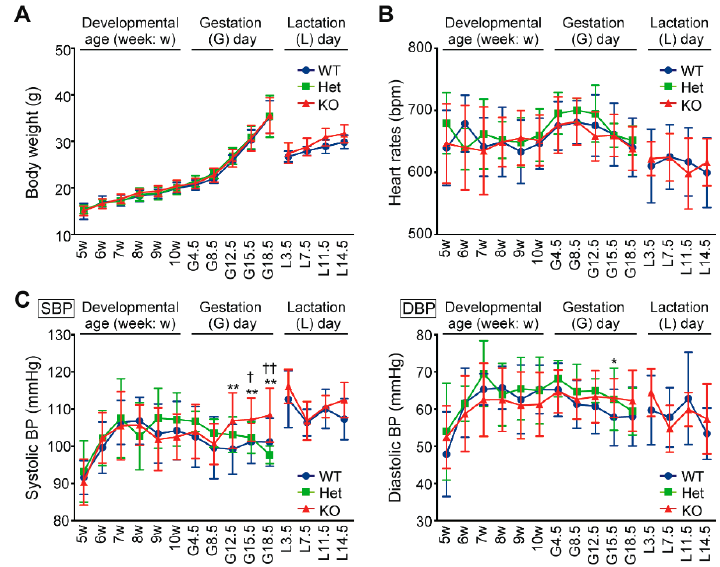
Figure 1. Pregnancy-induced hypertension in Cth − / − dams. Changes in body weights ( A ), heart rates ( B ), and systolic/diastolic blood pressures (SBP/DBP) ( C ) of wild-type ( Cth +/+ , WT, blue ), heterozygous ( Cth +/ − , Het, green ), and homozygous ( Cth − / − , KO, red ) female mice during juvenile development (5–10 week), gestation days (G4.5–G18.5), and lactation days (L3.5–L14.5). Blood pressures and heart rates were measured using a tail-cuff manometer. Data are represented as mean ± SD ( n = 9–18 for juvenile development, 21–22 for gestations days, and 5 for lactation days in Cth +/+ ; n = 7–12 for juvenile development and 5–6 for gestation days in Cth +/ − ; and n = 9–20 for juvenile development, 15–16 for gestation days, and 6 for lactation days in Cth − / − ). The differences between Cth +/+ and Cth − / − were significant at * p < 0.05 and ** p < 0.01 and those between Cth +/ − and Cth − / − were significant at † p < 0.05 and †† p < 0.01 in Student’s t -test.